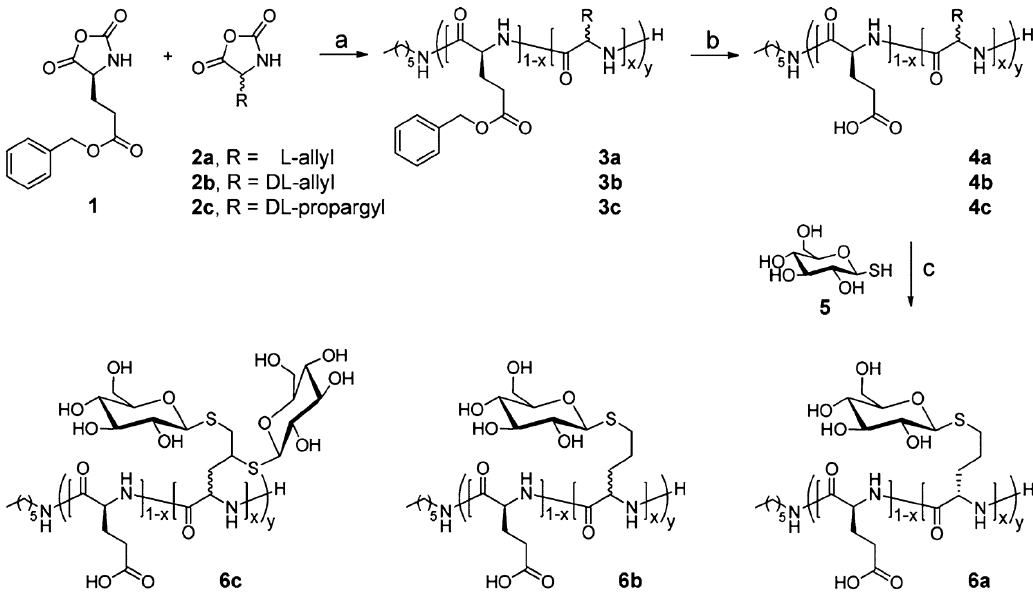
Figure 24. Synthesis of Glucocopolypeptides by NCA Copolymerization and Thiol-Ene/Yne Photochemistry. Reagents and conditions: (a) 1-hexylamine, DMF, 25 ◦ C, 7 days; (b) MSA/anisole/TFA, 0 − 20 ◦ C, 38 min; (c) Irgacure 2959, h ν , 0.1 M aqueous acetate buffer, 25 ◦ C, 12 h. Reproduced with permission from reference [42].